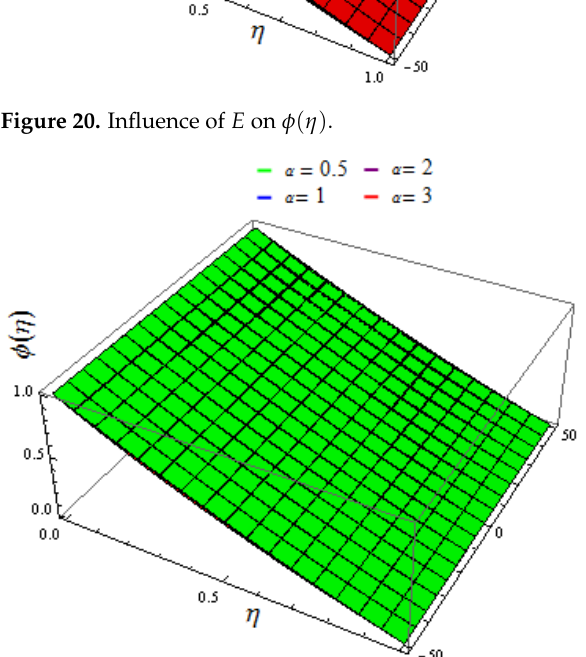
Figure 20. Influence of 𝐸 on 𝜙(𝜂) .